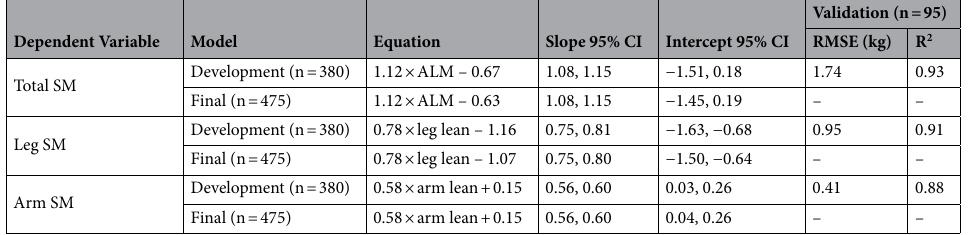
Leg. The leg SM mass prediction model (Table 3, Fig. 2C) had a validation R 2 of 0.91 and RMSE of 0.95 kg. No significant difference from the line of identity was observed for the slope (95% CI: 0.90, 1.02) or intercept (95% CI: −0.35, 1.30). Additionally, statistical equivalence was demonstrated (p < 0.001) between MRI leg SM and predicted leg SM using regions of 5% of MRI arm SM (0.61 kg). No significant proportional bias was observed in the Bland–Altman analysis (slope 95% CI: −0.06, 0.07; Fig. 2D). Arm. The arm SM mass prediction model (Table 3, Fig. 2E) had a validation R 2 of 0.88 and RMSE of 0.41 kg.